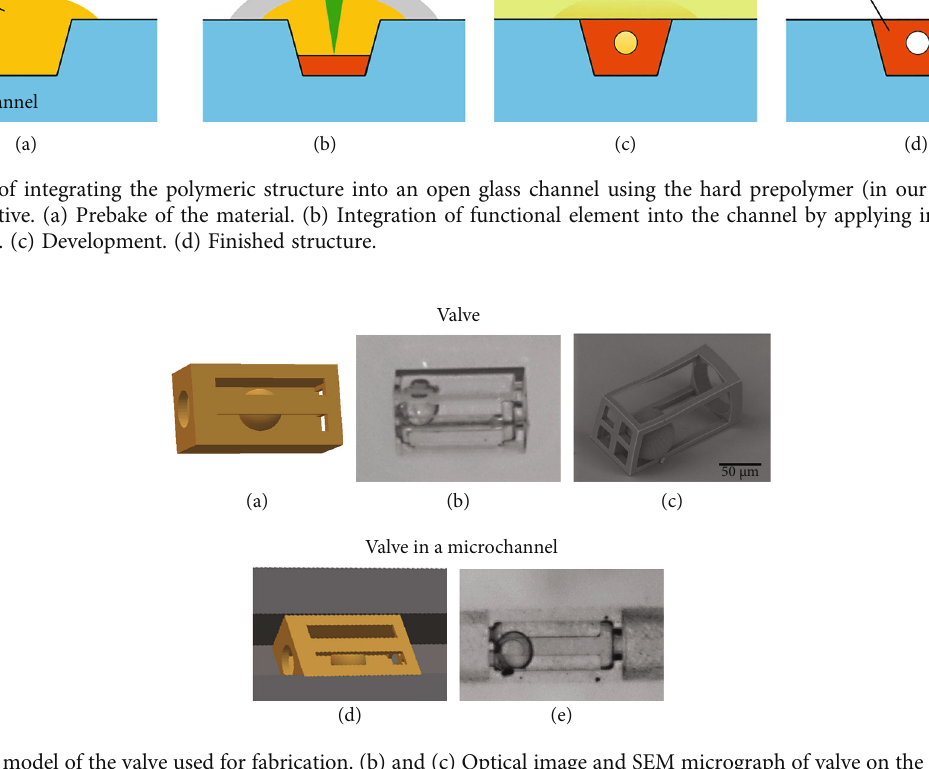
Figure 3: (a) 3D model of the valve used for fabrication. (b) and (c) Optical image and SEM micrograph of valve on the glass substrate. No deviations from the planned geometry can be detected. (d) 3D model of the valve inside the channel. (e) Integrated polymeric 3D valve inside the glass